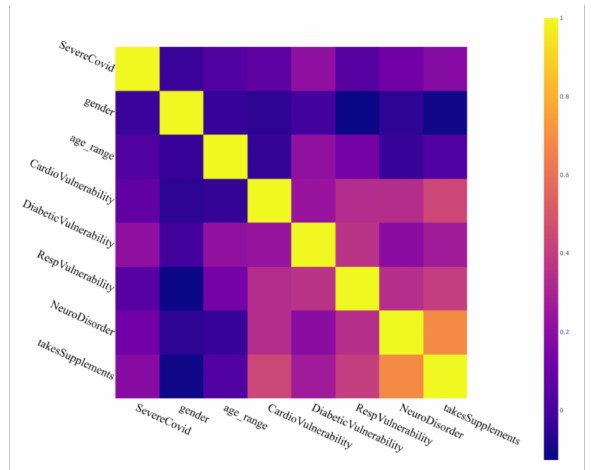
Figure 7. The correlation observed between some major health conditions and the overall SARS-Cov-2 state reported by the participants.